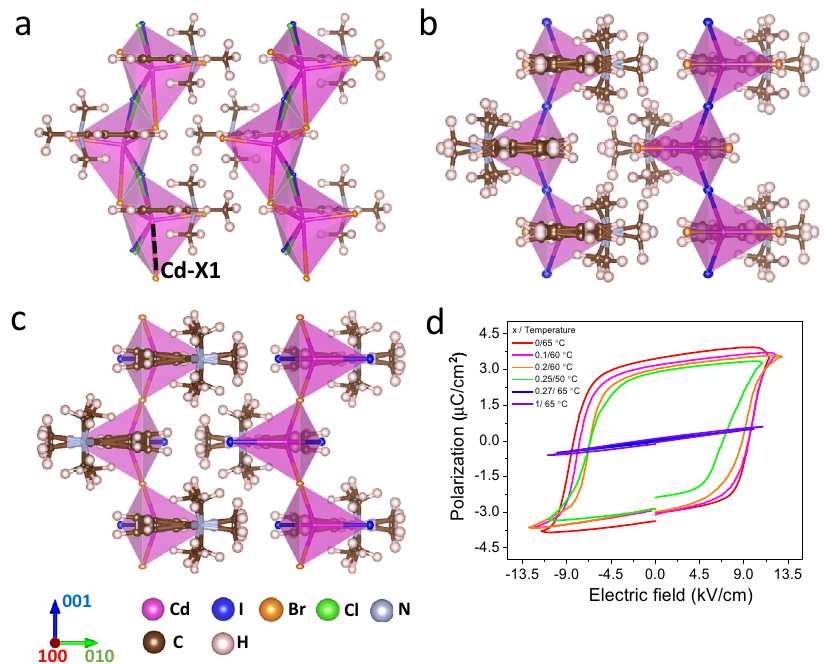
Fig. 1 | Crystalstructures and ferroelectric propertiesof C 6 H 5 N(CH 3 ) 3 CdBr 2 Cl 1-x I x . a – c Perspectiveofcrystallographicstructuresof x =0.25crystalinlow( a )andhigh ( b ) temperature phase and structure of x =1 composition ( c ). d PE diagram of this